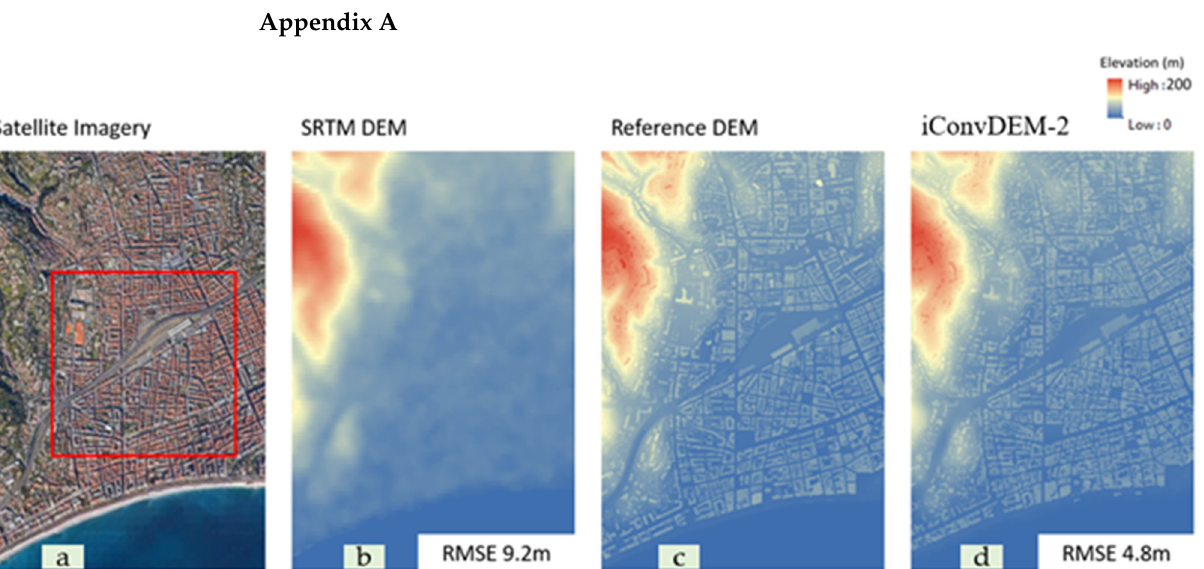
Figure A2. Plots at the testing site in the Orchard Road area (Singapore) of: ( a ) satellite image, ( b ) SRTM DEM, ( c ) reference DEM and ( d ) iConvDEM-2. References